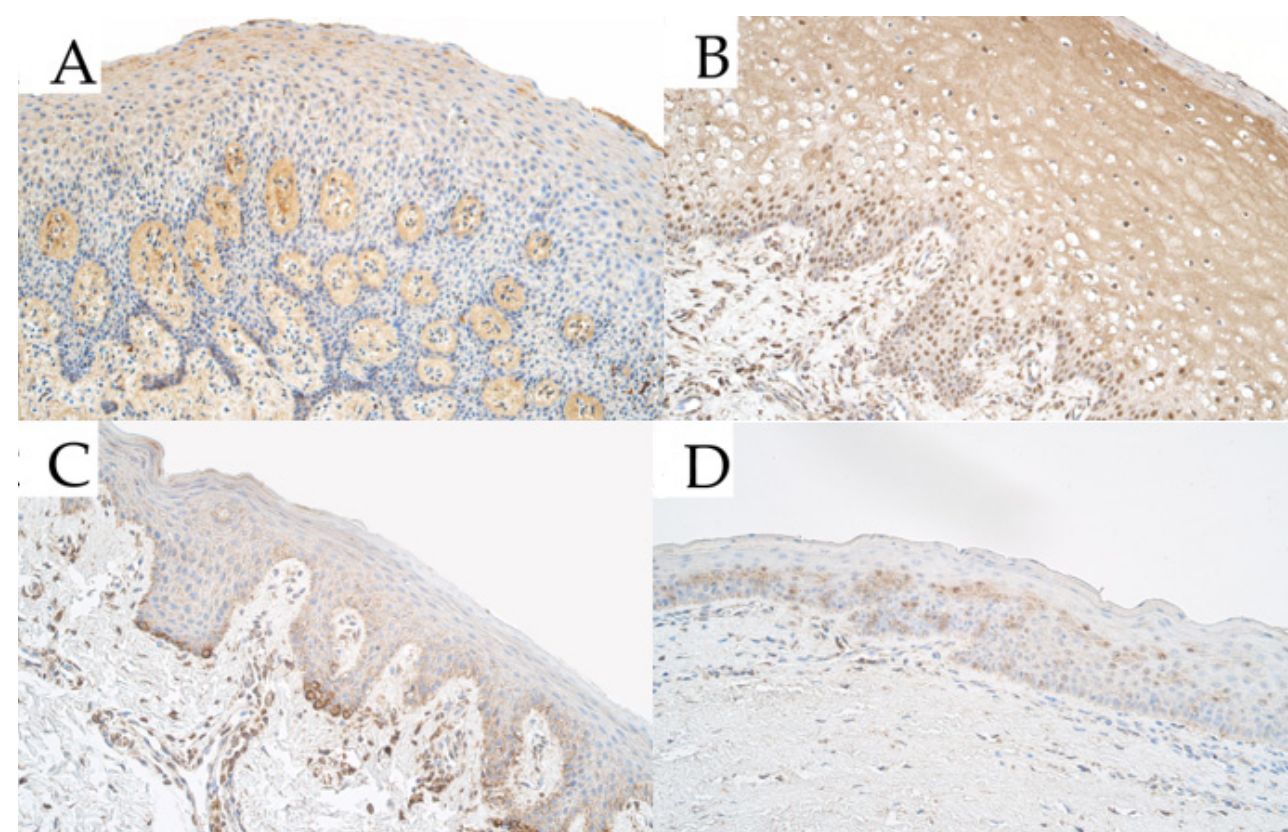
Figure 2. Immunoreactive structures for paired box 7 ( PAX7 ) in cleft affected tissue. ( A ) Control group tissue with moderate PAX7 -positive epitheliocytes in the epithelium and moderate to numerous PAX7 -positive structures in the connective tissue, PAX7 immunohistochemistry (IMH), 200 × . ( B ) Unilateral cleft lip affected tissue with numerous PAX7 -positive epitheliocytes in the epithelium and moderate to numerous PAX7 -positive cells in the connective tissue, PAX7 IMH, 200 × . ( C ) Bilateral cleft lip affected tissue with a moderate number of weakly stained PAX7 -positive epitheliocytes in the epithelium and few to moderate PAX7 -positive cells in the connective tissue, PAX7 IMH, 200 × . ( D ) Isolated cleft palate affected tissue with a few to moderate number of PAX7 -positive epitheliocytes in the epithelium and a few PAX7 -positive structures in the connective tissue, PAX7 IMH, 200 ×